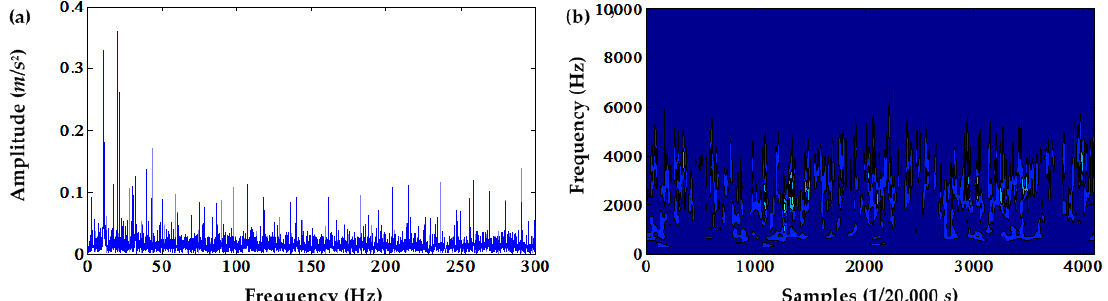
Figure 18. ( a ) Envelope spectrum of the time synchronous signal; ( b ) time-frequency contour of the envelope signal of the original signal.